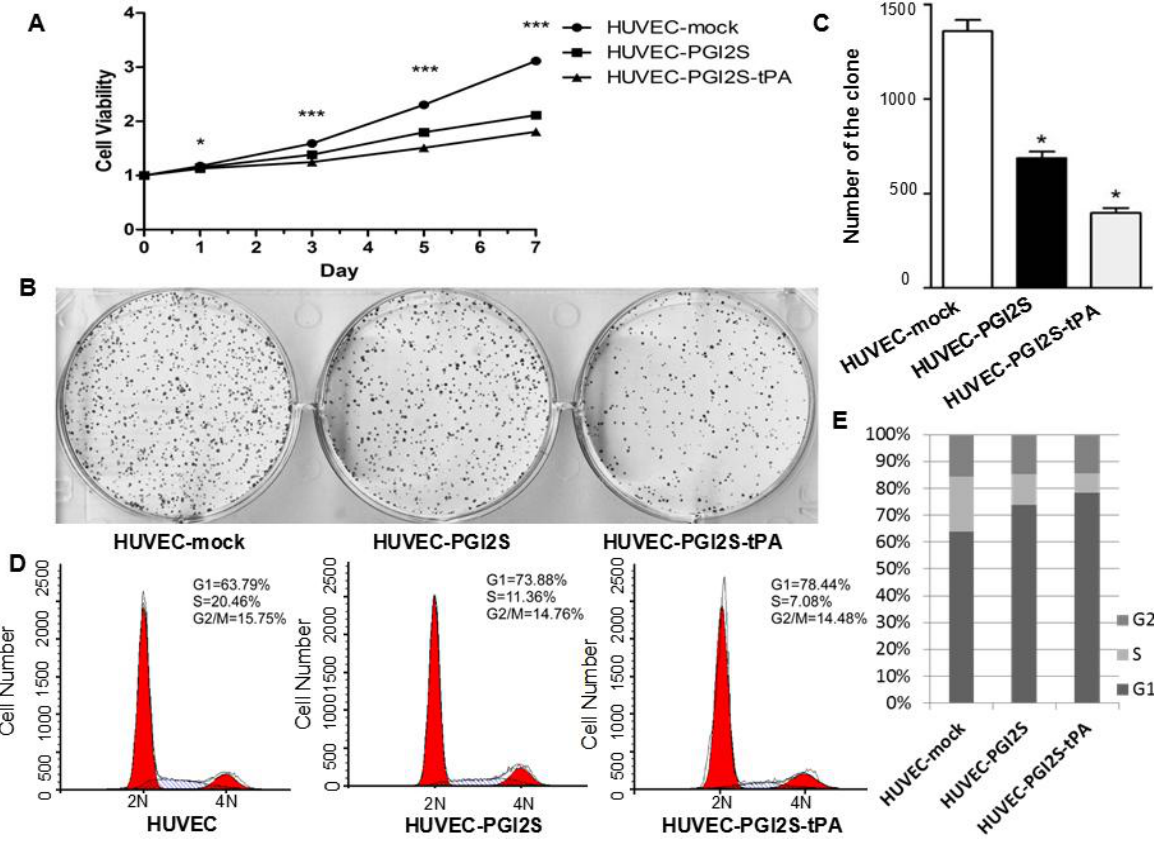
Figure 2. Cell growth and colony formation ability of HUVEC-mock, HUVEC-P GI2S and HUVEC- PGI2S-tPA cell lines. ( A ) Cell viability of HUVEC- PGI2S and HUVEC- PGI2S-tPA cells determined by the MTT assay. Growth curves are shown; data is expressed relative to cell viability on day 0. p values were calculated using independent samples t -test, * p < 0.05, and *** p < 0.001; ( B ) and ( C ) The plate colony formation assay was performed over 14 days, initially 1000 cells were seeded per well. The numbers of colonies formed were shown; three independent experiments were performed and P values were calculated using the independent samples t -test; ( D ) and ( E ) Cell cycle analysis of HUVEC-mock, HUVEC -PGI2S and HUVEC- PGI2S-tPA cell lines, and the percentage of cells at different phases of the cell